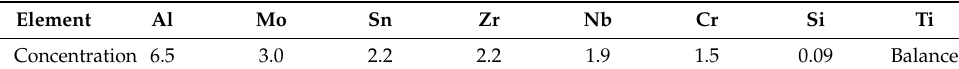
Table 1. Chemical composition of TC21 titanium alloy (wt.%).